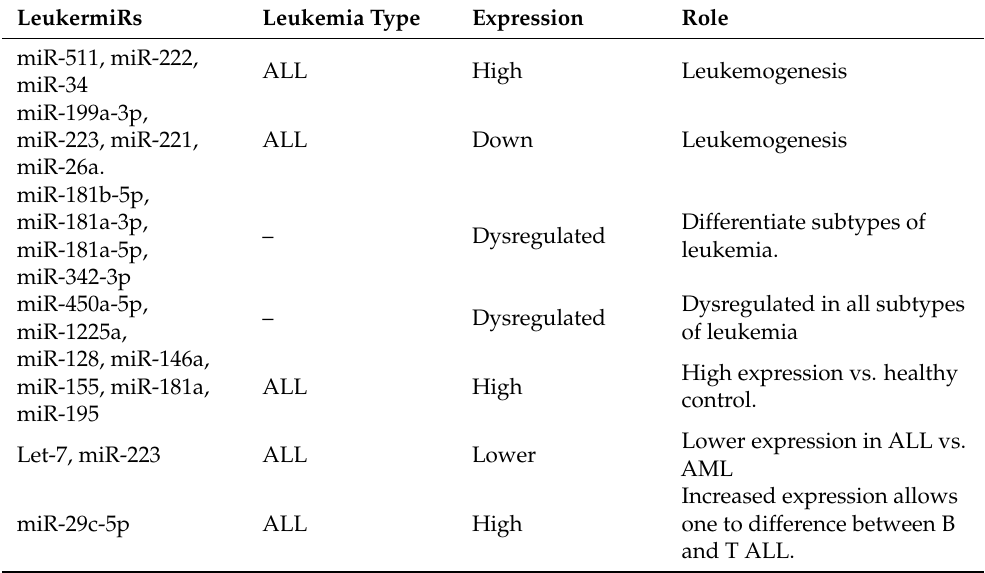
Table 3. microRNAs that have been reported as possible panel of micro-markers on different subtypes of